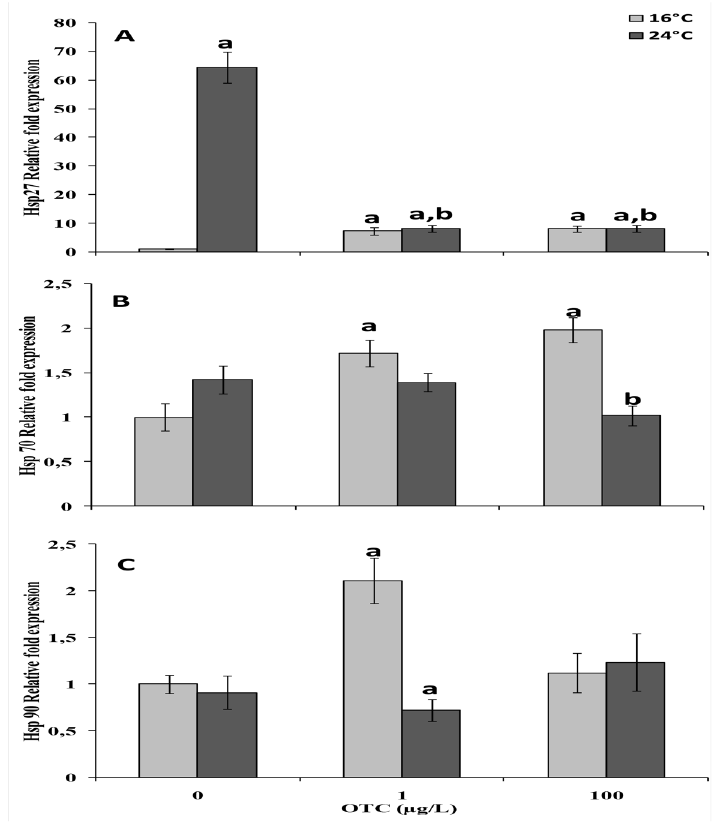
Fig 5. Expression of hsp27 (A), hsp70 (B), and hsp90 (C) mRNA in gills of mussels after a 4-day treatment with 1 or 100 μ g/L oxytetracycline at 16° and 24°C. Values are expressed as the mean ± Sd (n = 4) of the relative variations (fold change) between each treatment and the reference condition. a: significantly different from reference condition. b: significantly different from OTC-untreated mussels at 24°C (p <